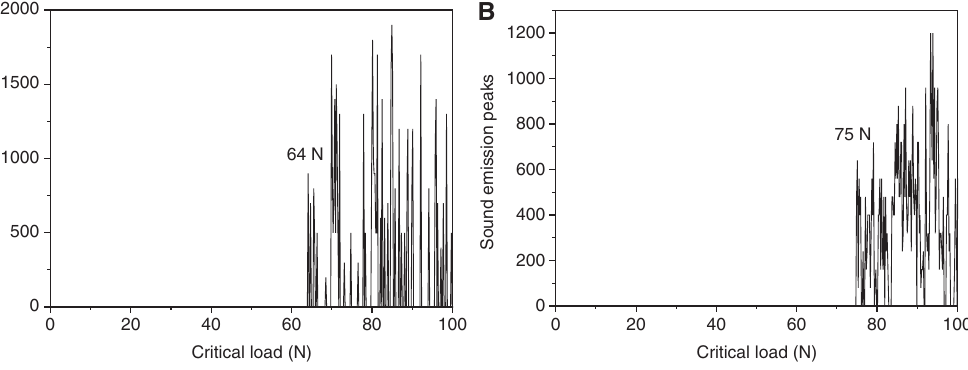
Figure 4: Scratch curve for plasma oxide coating: (A) Al α oxide coating and (B) AlY α oxide